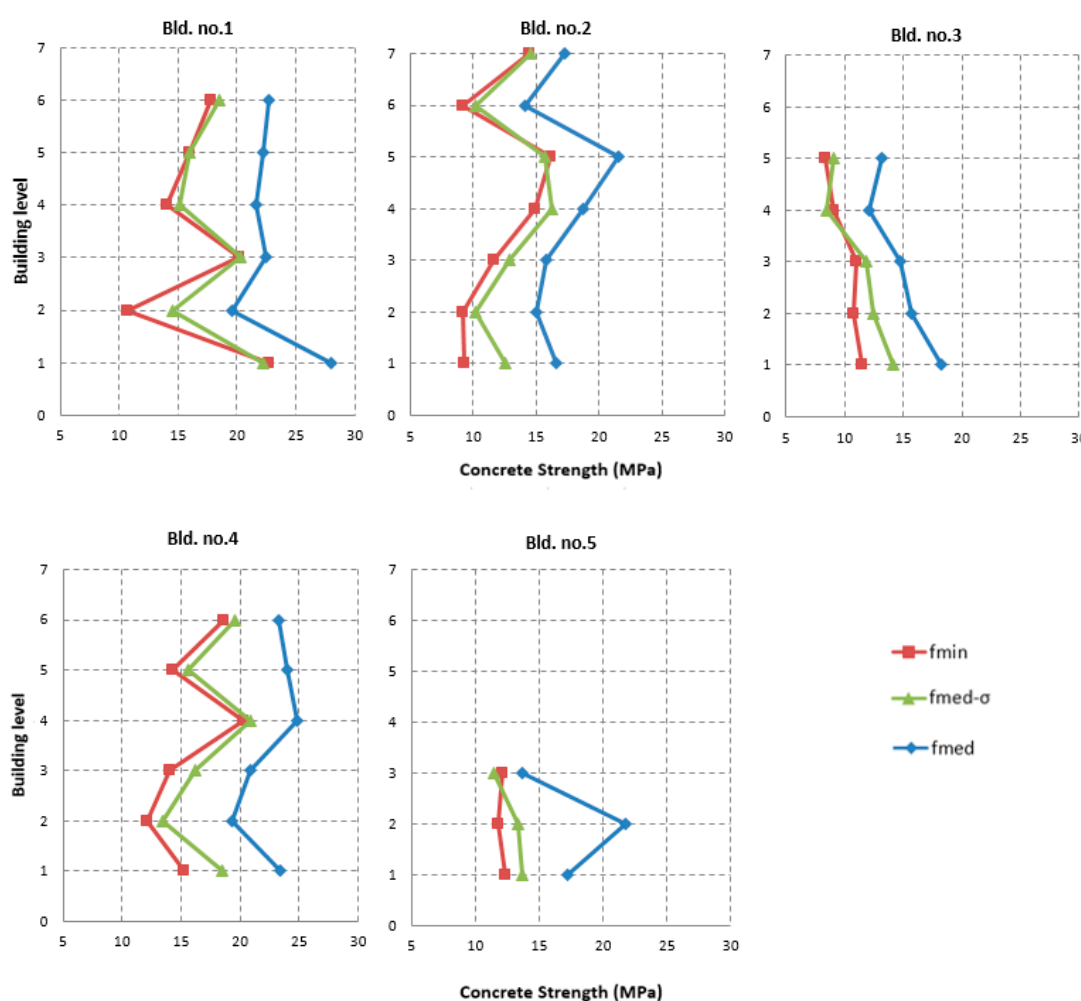
Figure 13. Comparison of the strength values at different heights for the five selected buildings.